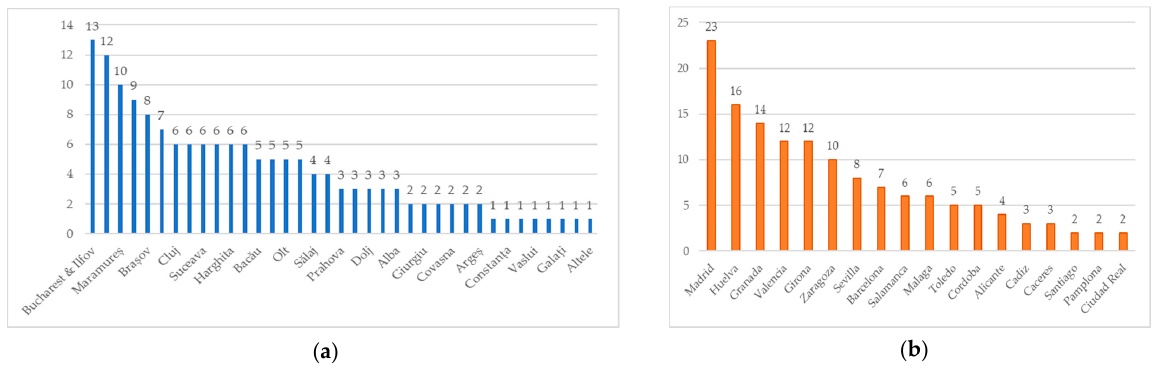
Figure 2. ( a ) Place of origin of Romanian hunters; ( b ) place of origin of Spanish hunters.